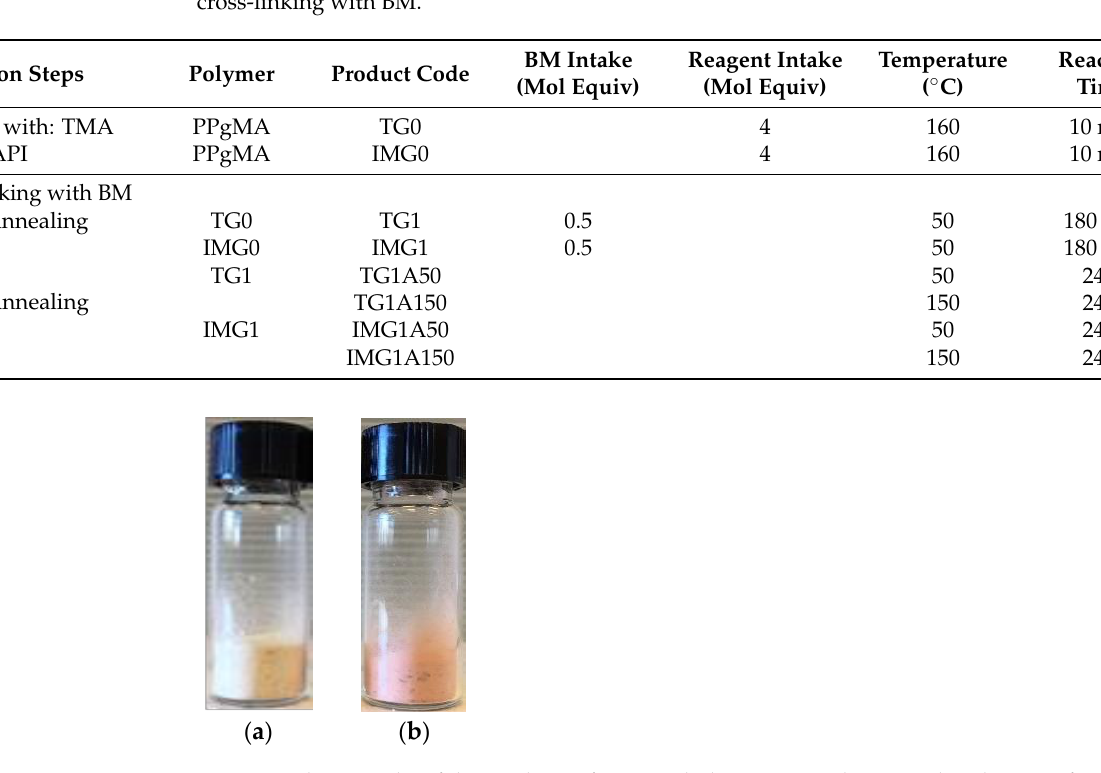
Figure 1. Photographs of the products after cross-linking reaction between thiophene grafted ( a ) and imidazole grafted; ( b ) products with BM.